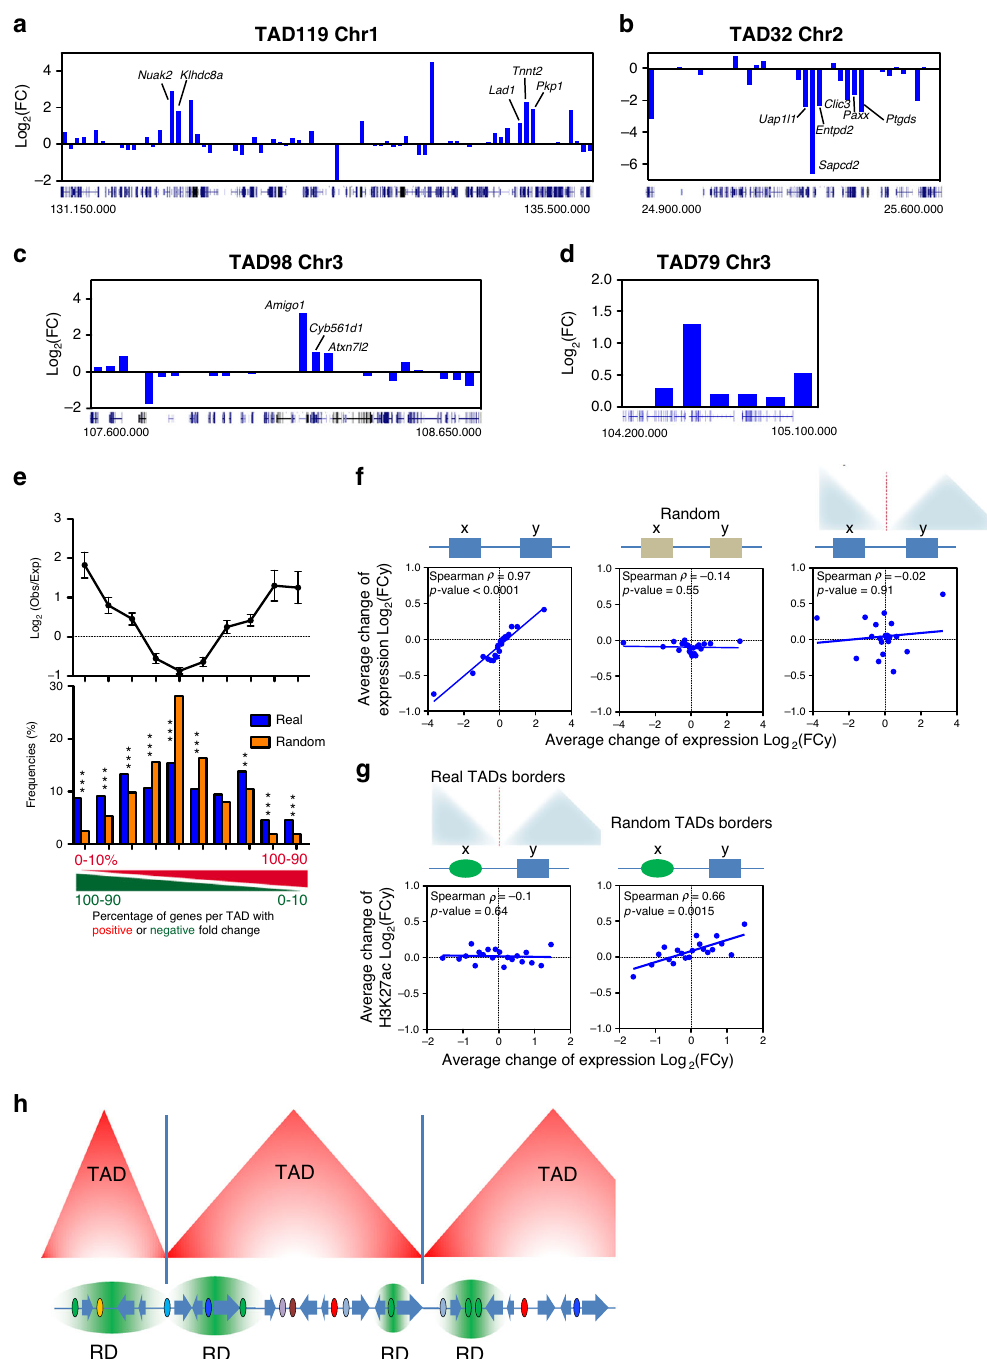
Fig. 7 TRDs Differ from TADs but are Constrained by TAD Borders. a – d Changes of mRNA levels (2 h TGF β versus vehicle) of genes contained at the indicated TADs. Co-regulated genes at TRDs are shown. e Top panel: ratio of observed versus expected frequencies of TADs with distinct proportions of genes with upregulated or downregulated FC (FC > 1 or FC < 1; 2 h TGF β versus vehicle). Values are means ± SD. Bottom: histogram of the frequencies of TADs for the observed (blue) or randomized (orange) position of genes. TADs ( n = 688) were binned into ten intervals depending on the percentage of up- versus downregulated genes. Signi fi cance was determined by comparing the real value with 500 randomizations of the gene order (see Methods). Probabilities ( p ) of the real number considering Normal distribution are provided. ** p ≤ 0.001; *** p ≤ 0.0001. Exact p -values are provided in Supplementary Data 5. Data for 12 h are given in Supplementary Fig. 15 c. f Correlation between change of expression (12 h TGF β versus vehicle) of every pair of expressed contiguous genes (x, y) of the genome using real chromosomal order (left), random gene order (middle) or pairs of contiguous genes separated by a TAD border (right). Spearman correlation coef fi cient and p -values are shown. Data were binned into 20 intervals. Data for 2 h are given in Supplementary Fig. 15d. g Correlation plot between change of H3K27ac signals of enhancers (ChIP-seq signal 2 h TGF β versus vehicle) and change of mRNA level (RNA- seq signal 2 h TGF β versus vehicle) of their closest gene separated by real (left), or by random TAD borders (right). Data were binned into 20 intervals. Data for 12 h are given in Supplementary Fig. 15e. h Model of in fl uence of TGF β -regulatory domains (TRD) and other regulatory domains (RD) constrained by the insulating activity of TAD borders. Small TADs can harbor a single RD. Source data are provided as a Source Data fi